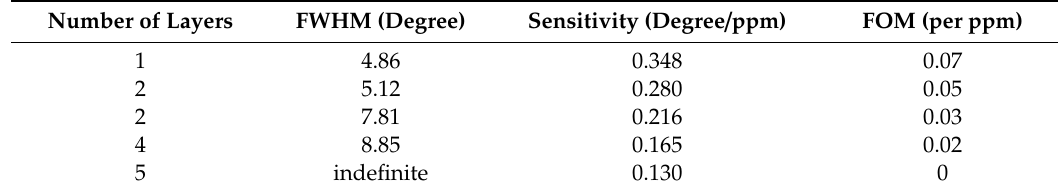
Figure 7. Sensitivity versus number of chitosan-PEG layers. Table 2. Performance characteristics of chitosan-PEG SPR acetone vapor sensor based on 1, 2, 3, 4, and 5 deposited layers of chitosan-PEG films.